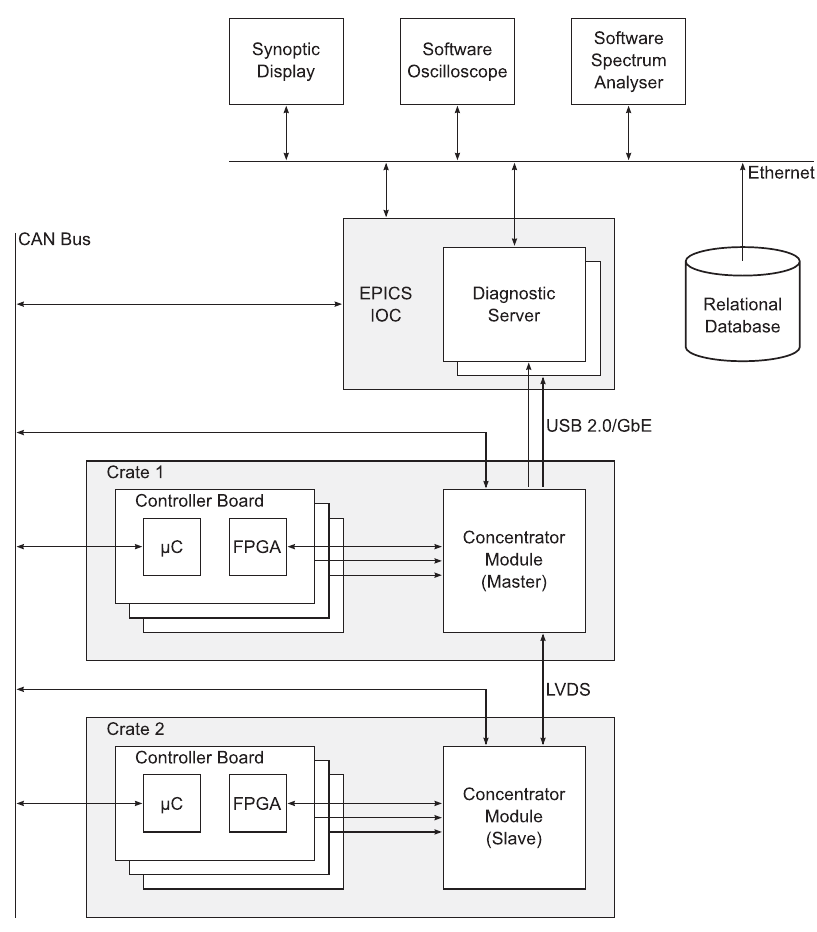
FIG. 5. Data flow between controller boards, concentrator modules, diagnostic server, and